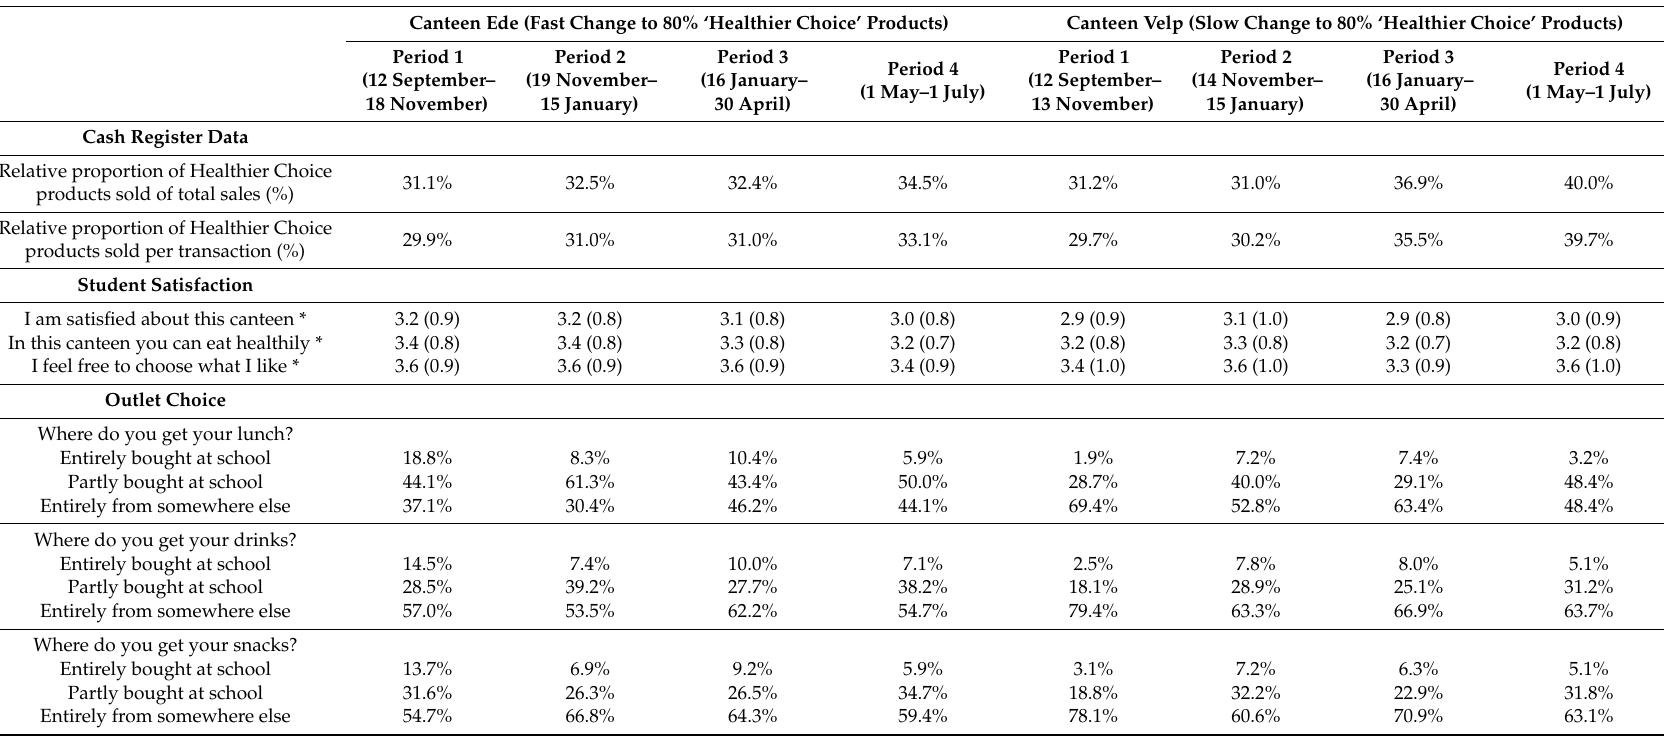
Table 4. Outcome measures of cash register and survey data in each of the four periods in two